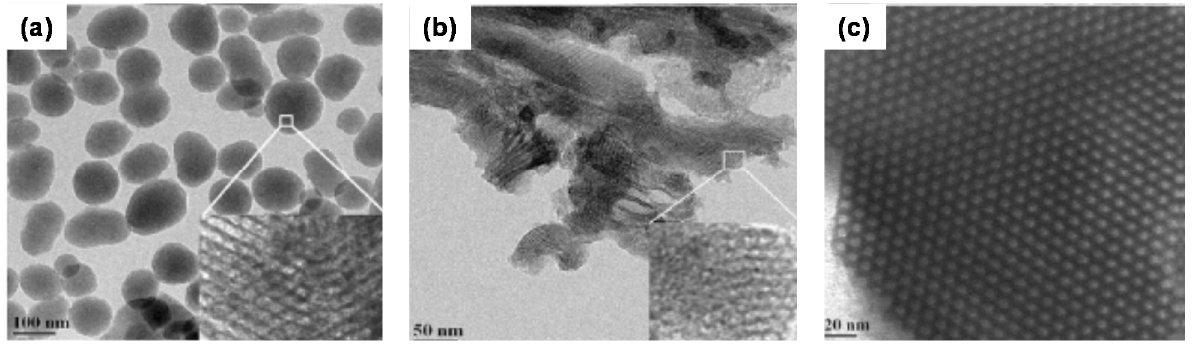
Figure 1. TEM micrograph of MCM-41 ( a ); FSM-16 ( b ); and SBA-15 ( c ). Reproduced with permission of Ref.